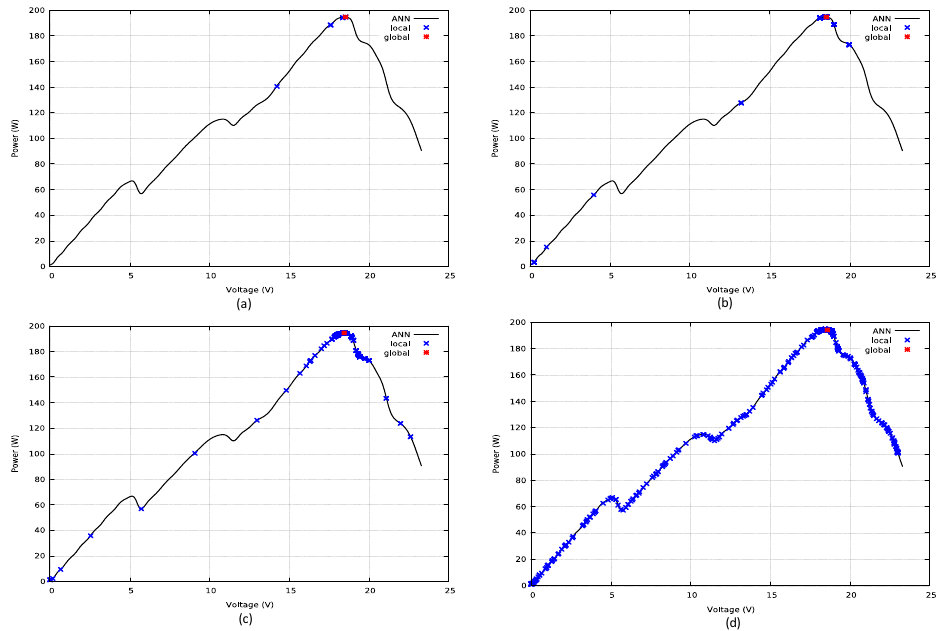
Figure 6. Results obtained with the algorithms for the test function 0: ( a ) GSS; ( b ) SA (T = 0.5); ( c ) SA (T = 100); ( d ) SA (T = 1000).